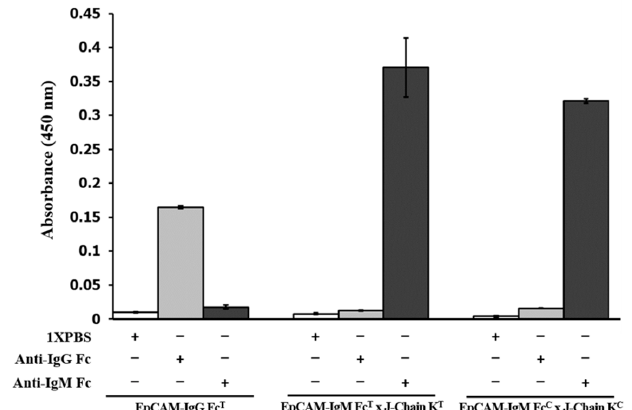
Figure 9. Enzyme-linked immunosorbent assay (ELISA) was performed to confirm binding interaction between anti-IgM Fc µ -chain antibody and EpCAM–IgM Fc × J-ChainK purified from F 1 transgenic Chinese cabbage plant. Each ELISA plate well was coated with 10 ng of the purified